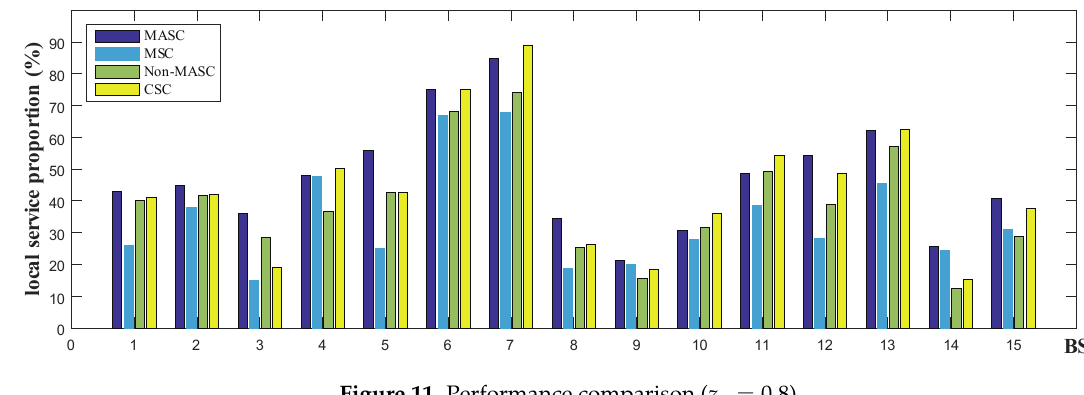
Figure 11. Performance comparison ( z p = 0.8).